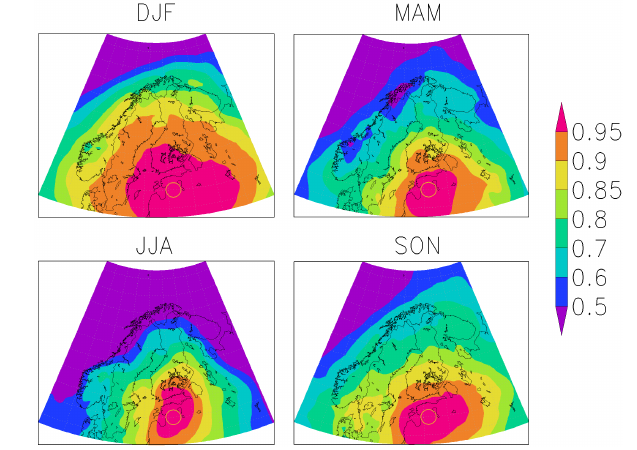
Figure 1. Correlation maps of air temperature at the 1000hPa level for the testing point in the Baltic Sea